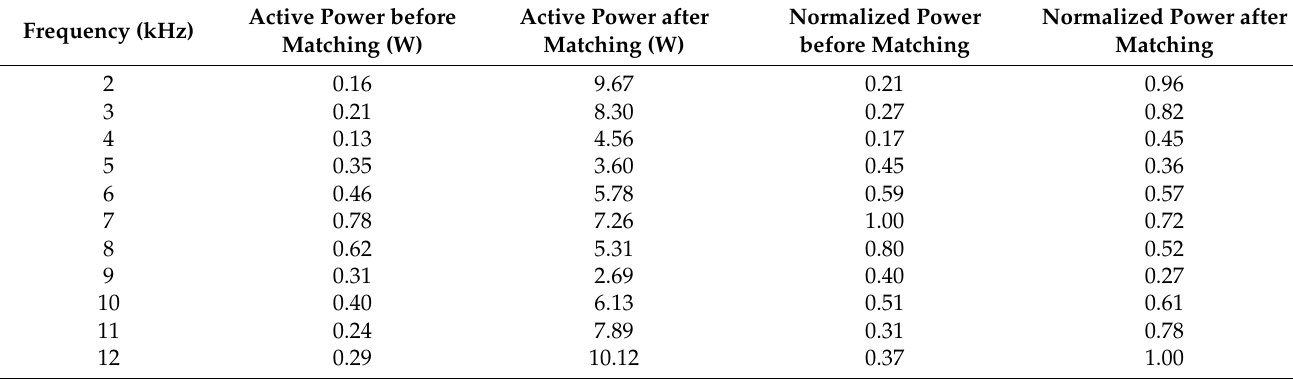
Table 1. The measured active power in the preset frequency band of the transducer before and after impedance matching. Frequency